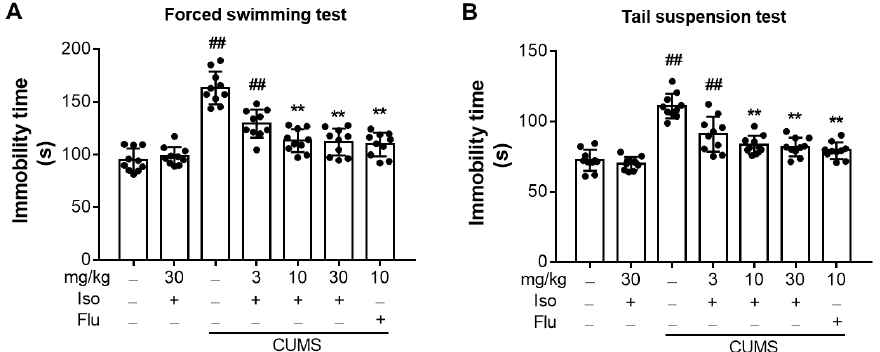
Figure 5. Isofraxidin alleviates CUMS-induced increase of immobility duration in FST and TST. ( A ) Duration of immobility in FST. ( B ) Total immobility time in TST. Data are presented as means ± SEM ( n = 10). The Control group was CUMS-free mice administered with normal saline. CUMS group was CUMS mice. Significance was analyzed by one-way ANOVA followed by the Bonferroni correction. ## p < 0.01, compared with the control group. ** p < 0.01, compared with CUMS group.